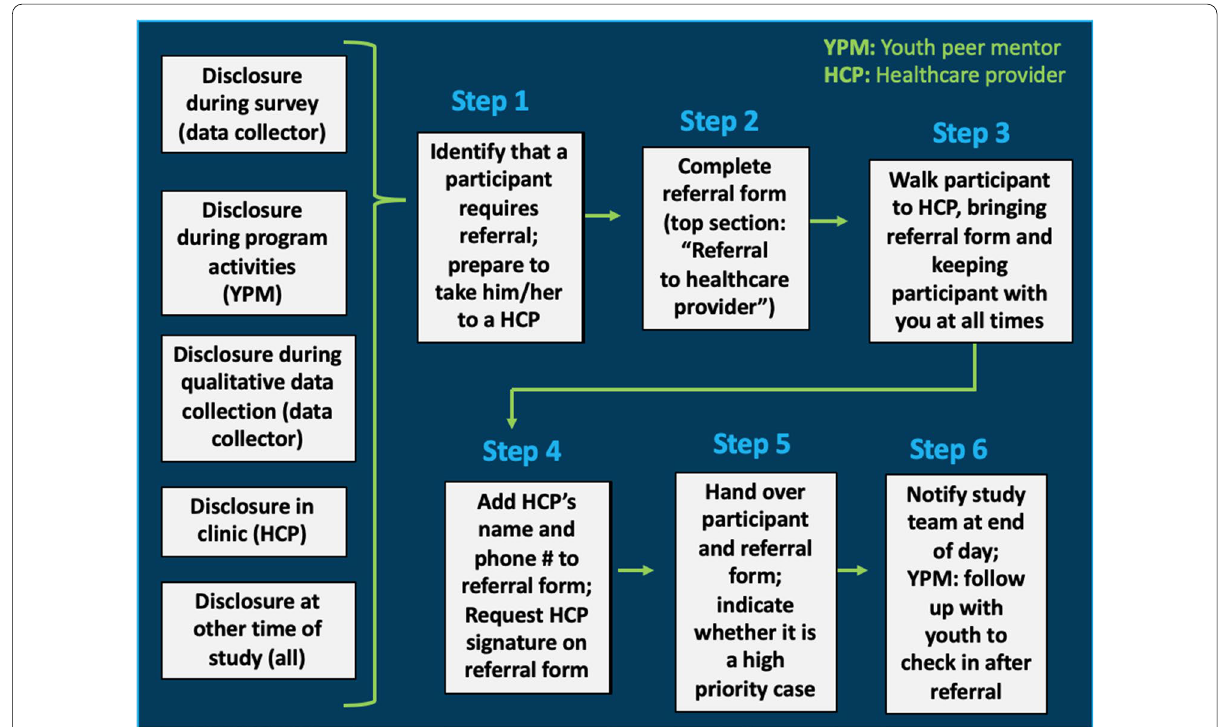
Fig. 1 Summary of referral procedures for staff and youth peer